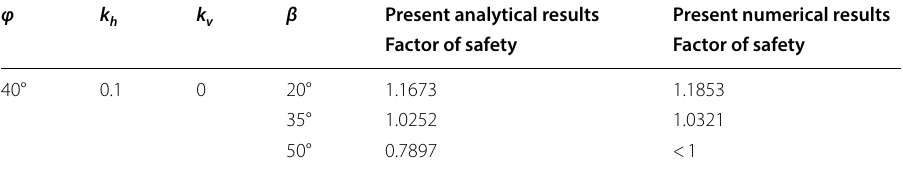
In the above table, factor of safety less than one indicate that prescribed ultimate state not reached i.e. soil body collapsed before taking fully plastic equilibrium